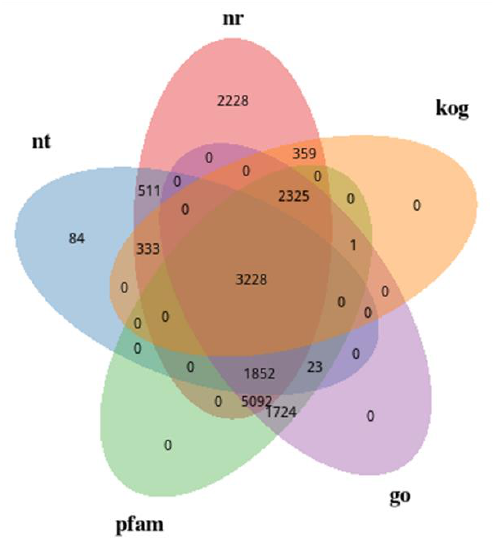
Figure 8. Venn diagram of unigenes annotated in five annotation databases.